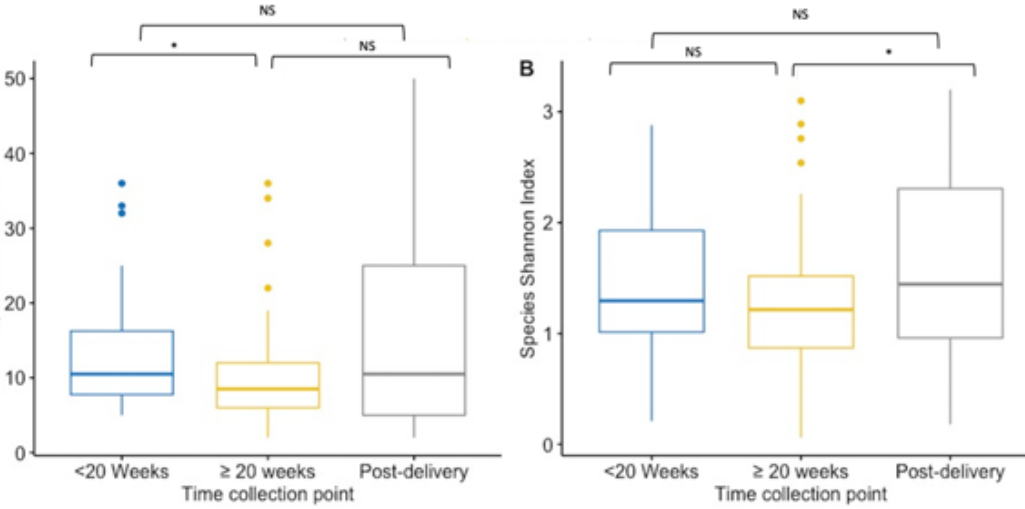
Figure 1. Boxplot for the richness ( A ) and Shannon diversity index ( B ) at the species level for each collection point. Results of the <20 weeks GA pregnancy collection are in blue ( n = 44), ≥ 20 weeks GA pregnancy collection in yellow ( n = 82), and post-delivery in grey ( n = 44). ( A ) Species richness is lower at ≥ 20 weeks GA pregnancy collection compared to the pregnancy collection at <20 weeks GA ( p = 0.02). Between the other timepoints there was no significance difference. ( B ) The Shannon diversity index is higher at post-delivery compared to the index at ≥ 20 weeks GA pregnancy collection ( p = 0.03), but not compared to the diversity index at <20 weeks GA pregnancy collection. During the pregnancy, the index did not differ significantly. NS = non significant. * p -value <